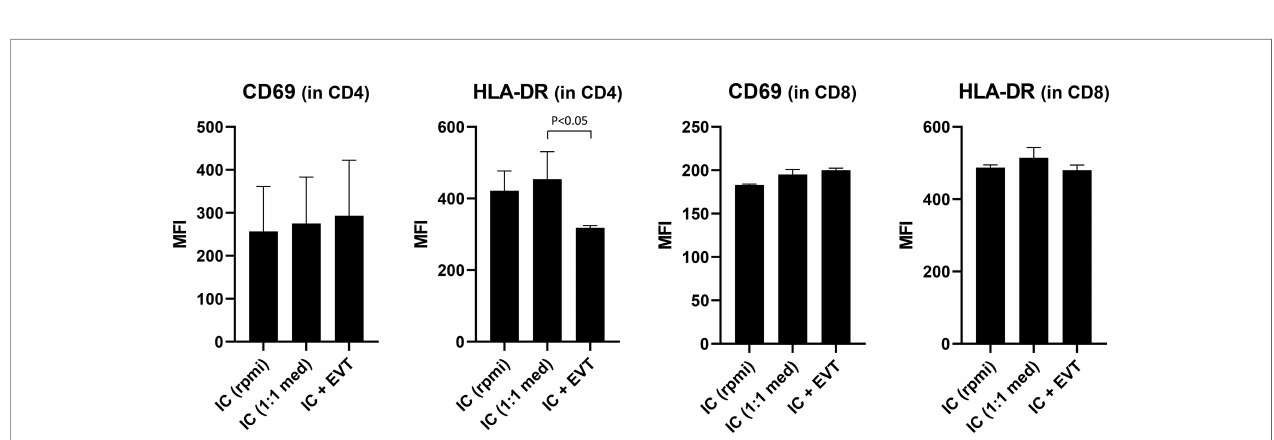
FIGURE 7 | Cytokine secretion by trophoblasts in the culture medium. The level of 20 different cytokines and growth factors was analyzed by Luminex analysis in the medium from four cultures (QG1, QG2, RG3, and QH1 in triplicate). IL-2, IL-5, IL-6, IL-8, and TNF- a were detected above the minimum threshold value and are shown in this fi gure. The graph shows medians and the whiskers representing minimum and maximum values.